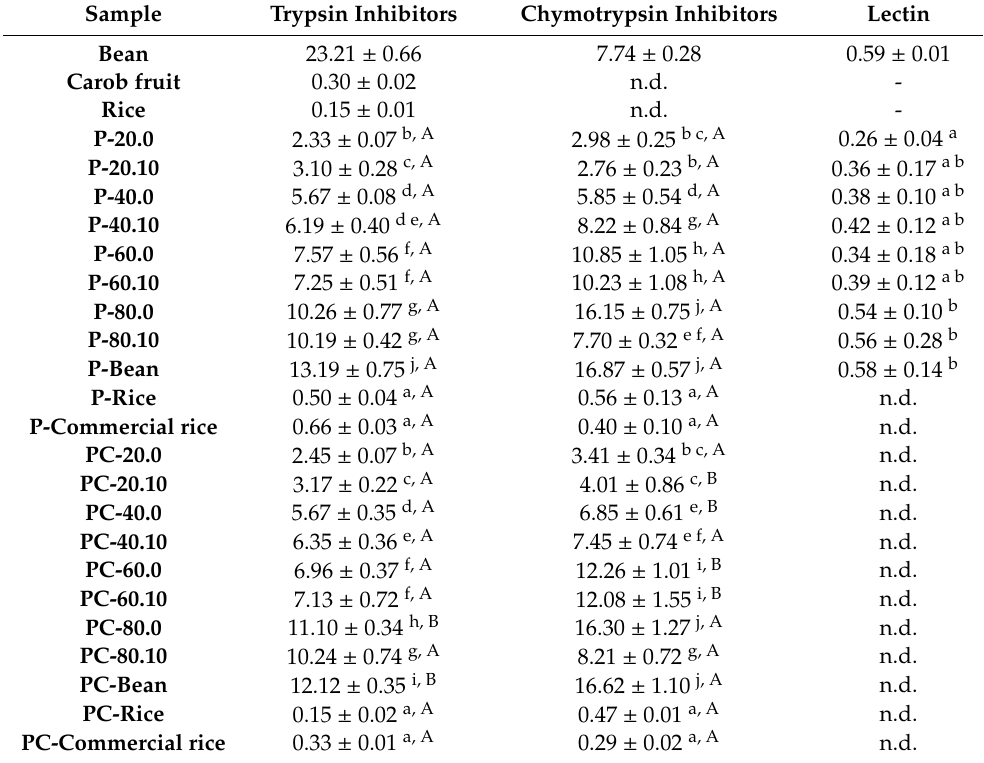
Table 4. Content of trypsin inhibitors (TIU / mg dry weight), chymotrypsin inhibitors (CIU / mg dry weight), and lectin content (%PHA) in the uncooked (P-) and cooked (PC-) fettuccine samples and in the commercial rice